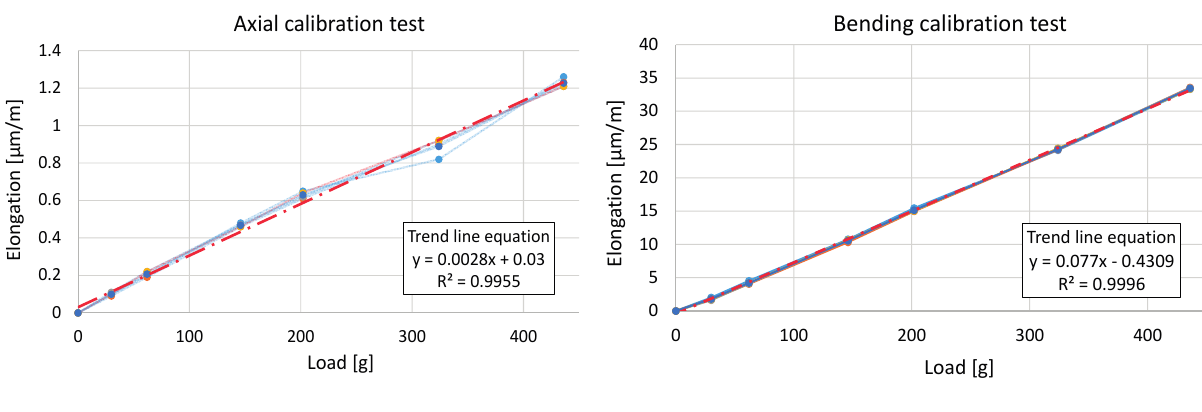
Figure 7. Sensor calibration tests: ( Left ) for axial loadings; ( Right ) for bending